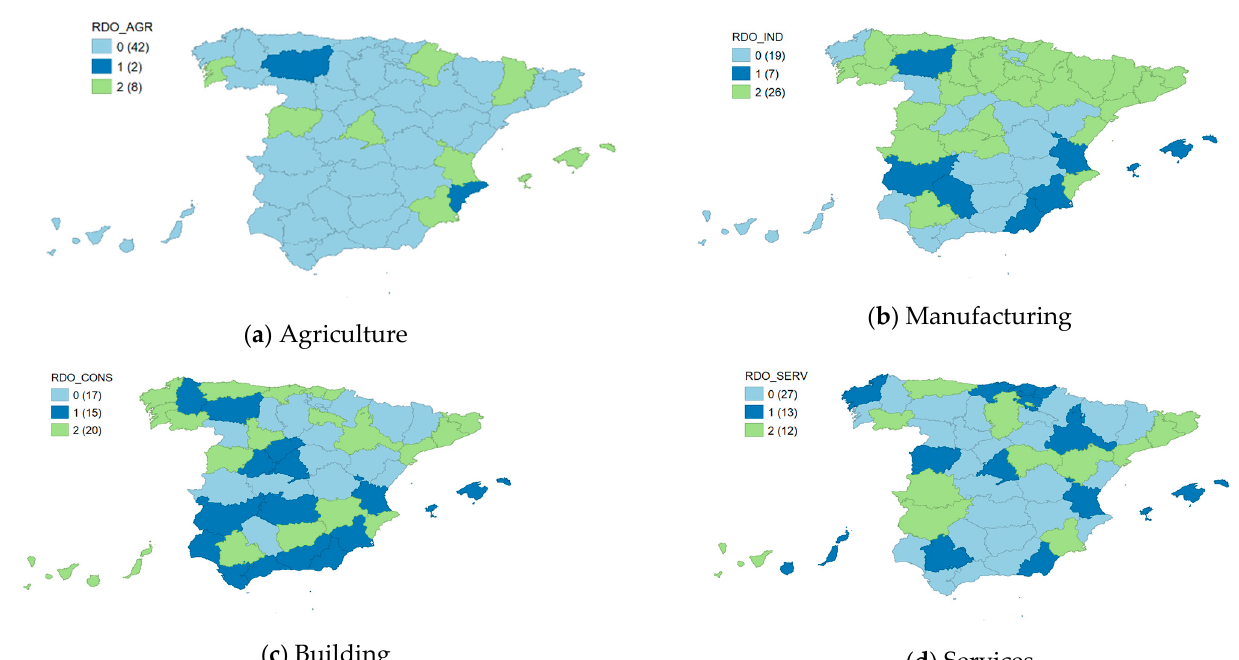
Figure 8. Industry distribution of bankruptcy outcomes.